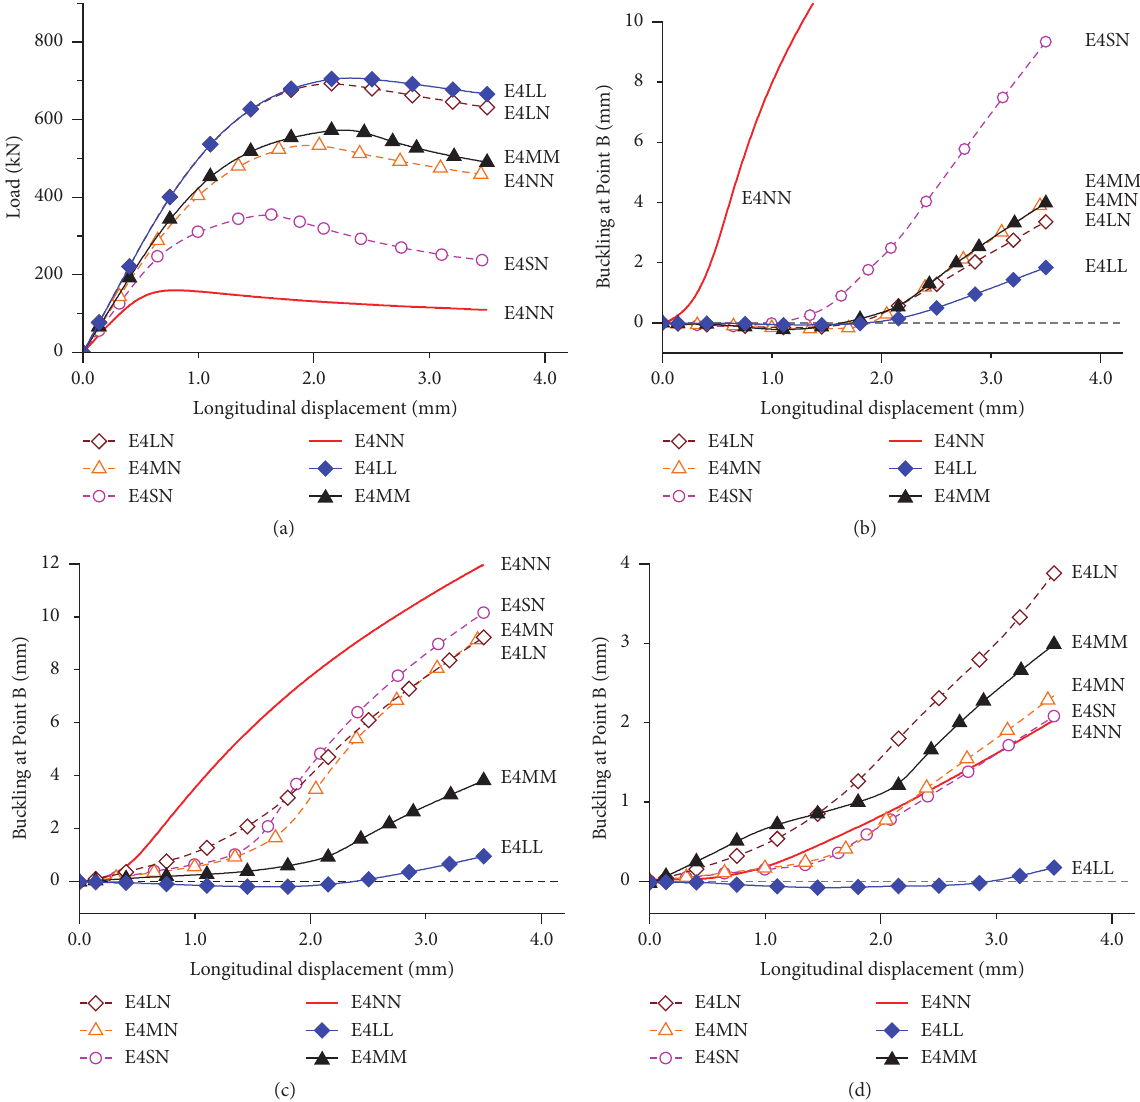
Figure 10: Load-displacement and buckling-displacement curves 2: (a) load-displacement curves; buckling-displacement curves at (b) Point A, (c) Point B, and (d) Point